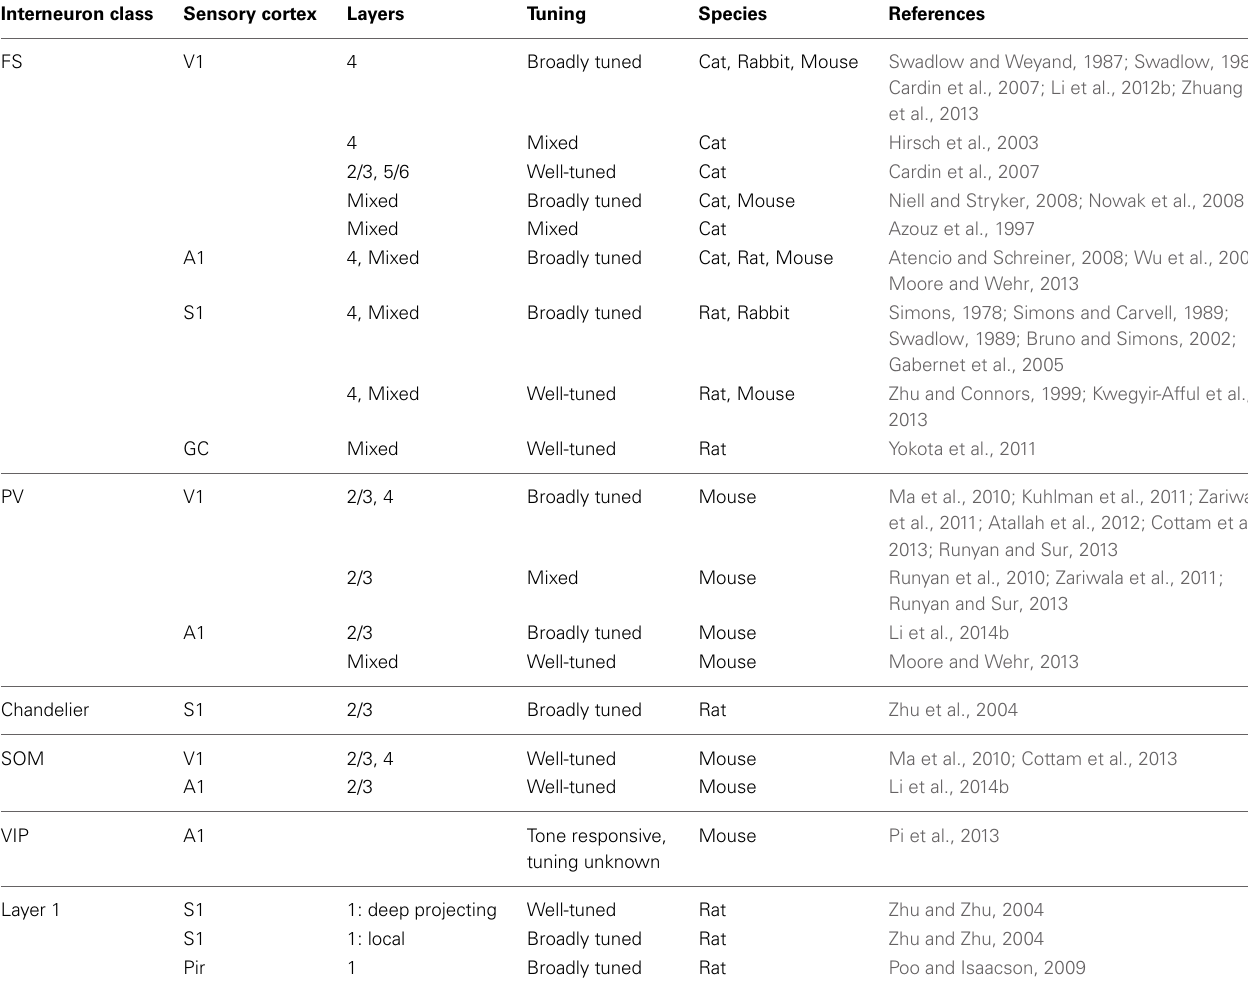
Table 3 | Tuning width of inhibitory neurons by cell